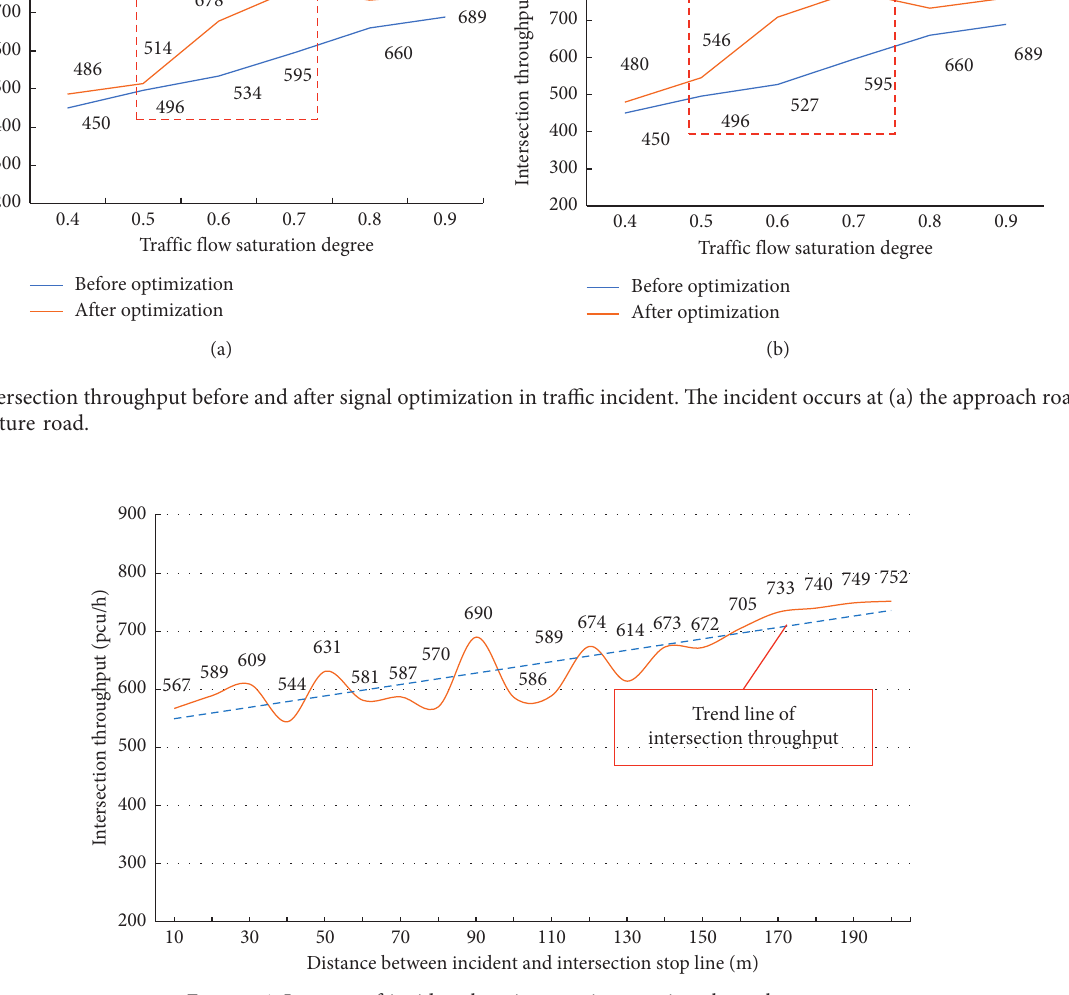
Figure 6: Impacts of incident locations on intersection throughput.